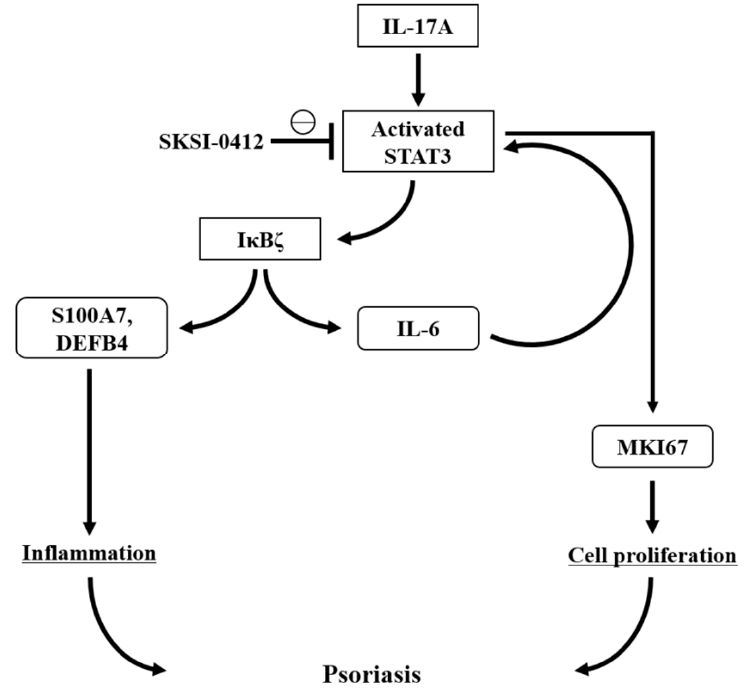
Figure 5. Model of the molecular mechanism of STAT3 and the role of SKSI-0412 in psoriasis skin. IL-17A induces phosphorylation of STAT3 in the keratinocytes. Activated STAT3 induces I κ B ζ which then transcriptionally up-regulates antimicrobial peptides (S100A7 and DEFB4) and cytokine (IL-6) involved in the pathogenesis. The treatment of SKSI-0412 inhibits phosphorylation of STAT3 and normalizes skin inflammation and cell proliferation.